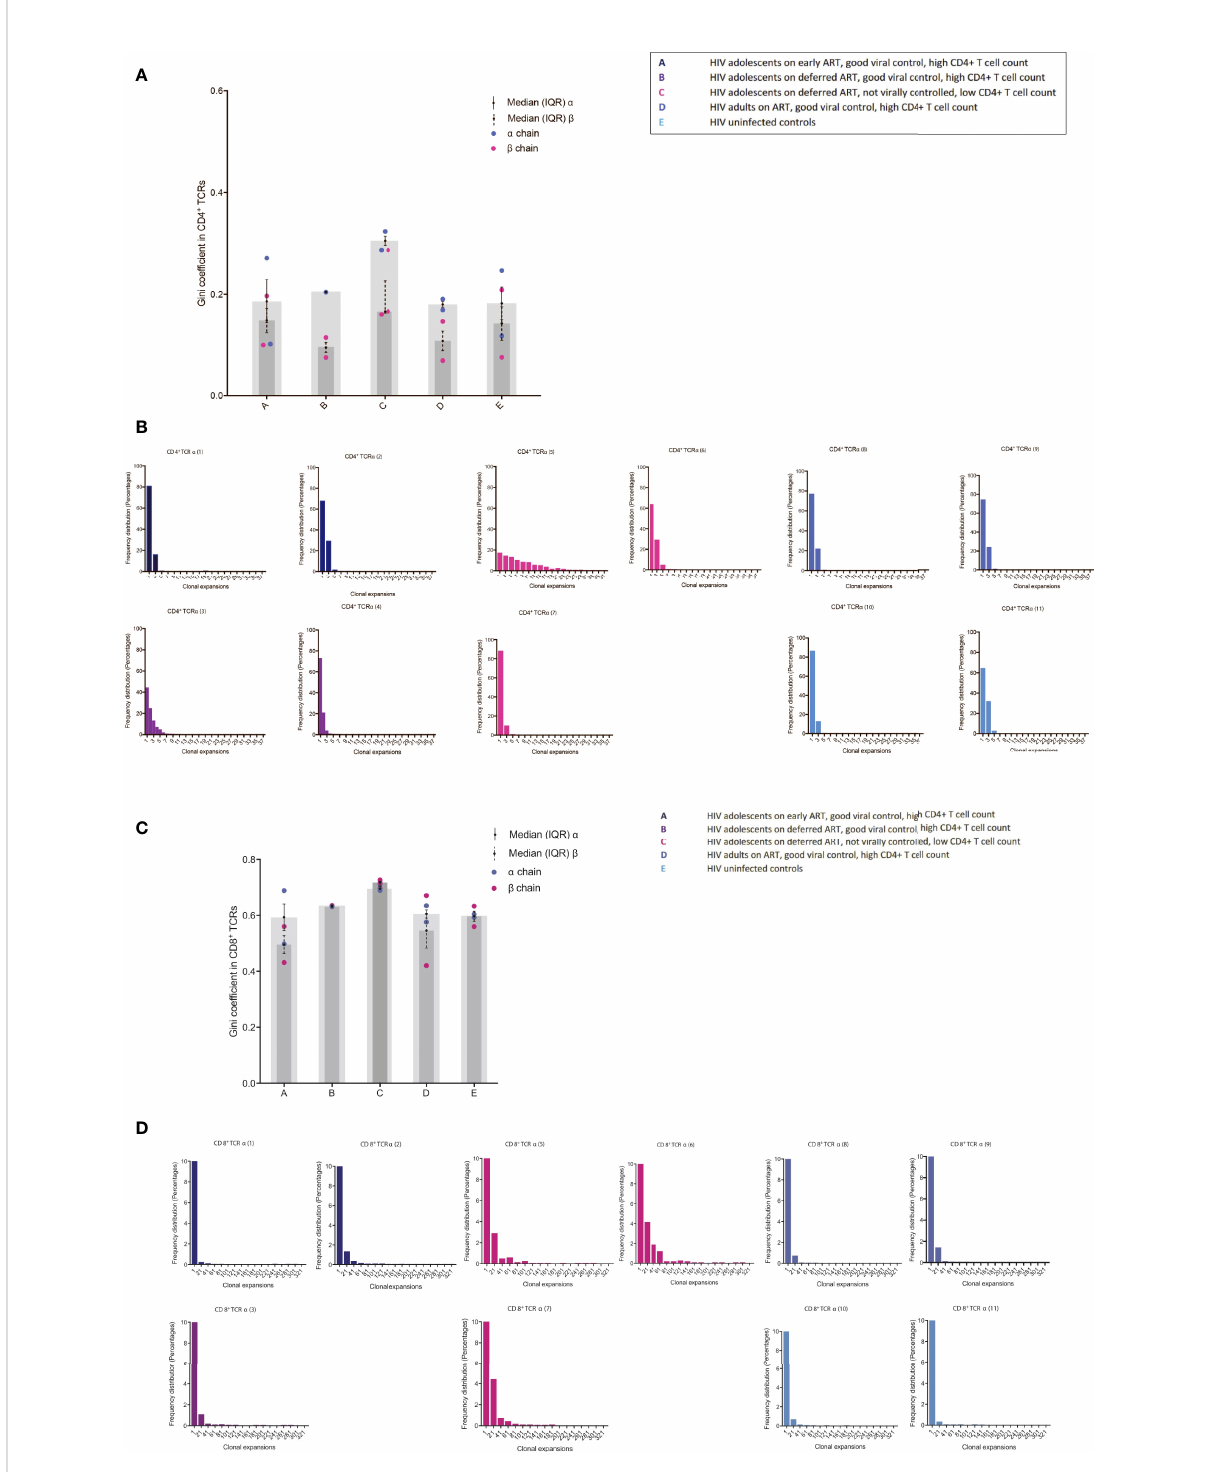
FIGURE 2 TCR abundance distribution in CD4 + and CD8 + T cells in adolescents with different responses to HIV-1 (A) The degree of clonal expansion in the CD4 + TCR repertoire measured using the Gini coef fi cient in TCR alpha (blue) and TCR beta sequences (pink). (B) Individual TCR sequence abundance distribution in the CD4 + TCR repertoire. (C) The degree of clonal expansion in the CD8 + TCR repertoire measured using the Gini coef fi cient in TCR alpha (blue) and TCR beta sequences (pink). (D) Individual TCR sequence abundance distribution in the CD8 + TCR repertoire. Black lines: